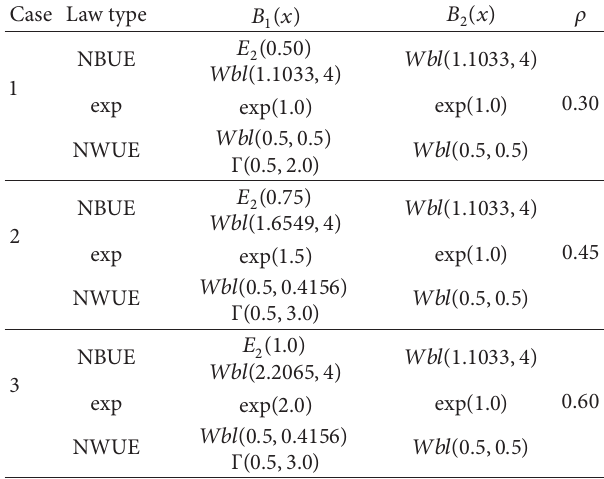
Table 1: Different simulation cases for fixed parameters 𝜆 = 0.3 , 𝛼 = 1 , and ] = 0.2